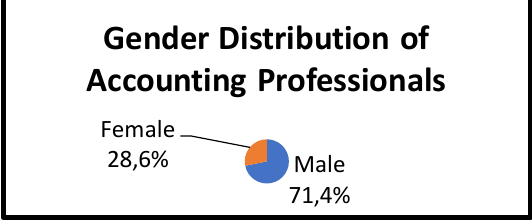
Figure 1. Gender Distribution of